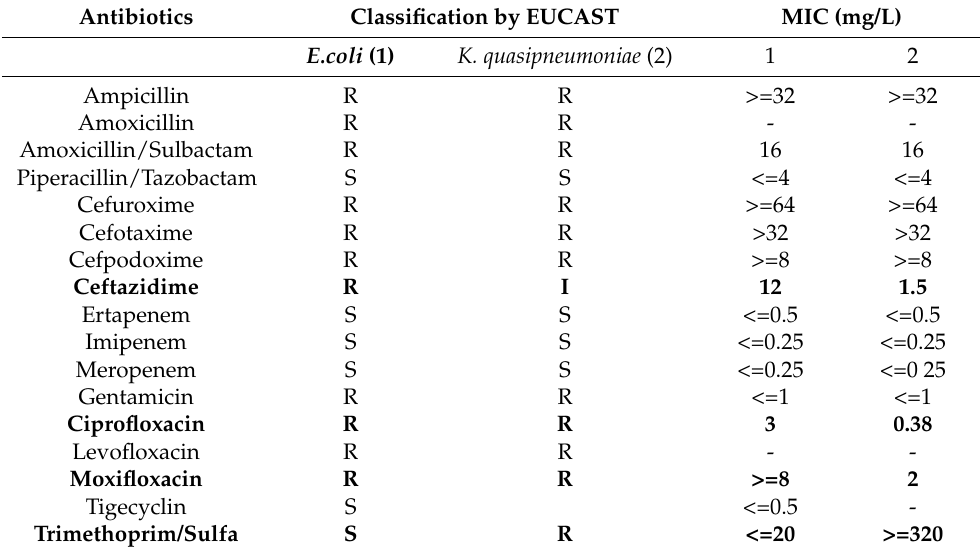
Table 1. Antibiotic susceptibility of MDRB isolates. MIC = minimum inhibitory concentration; EUCAST = European Committee on Antimicrobial Susceptibility Testing; R = resistant; S =